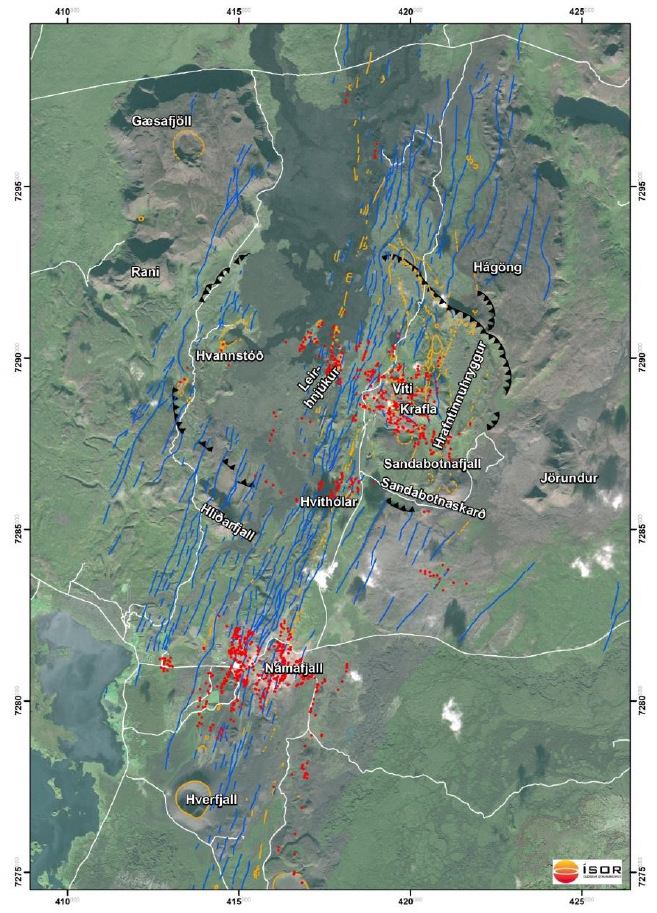
Figure 2. An overview of the Krafla area and the central part of the fissure swarm. The figure shows the visible 110 ka caldera (black), faults and fissures close to Krafla (blue), craters and eruptive fissures (orange) and geothermal manifestations (red). The figure also shows the subsidiary geothermal area in Námafjall, south of Krafla. Coordinates are UTM, WGS84, zone 28 in km.